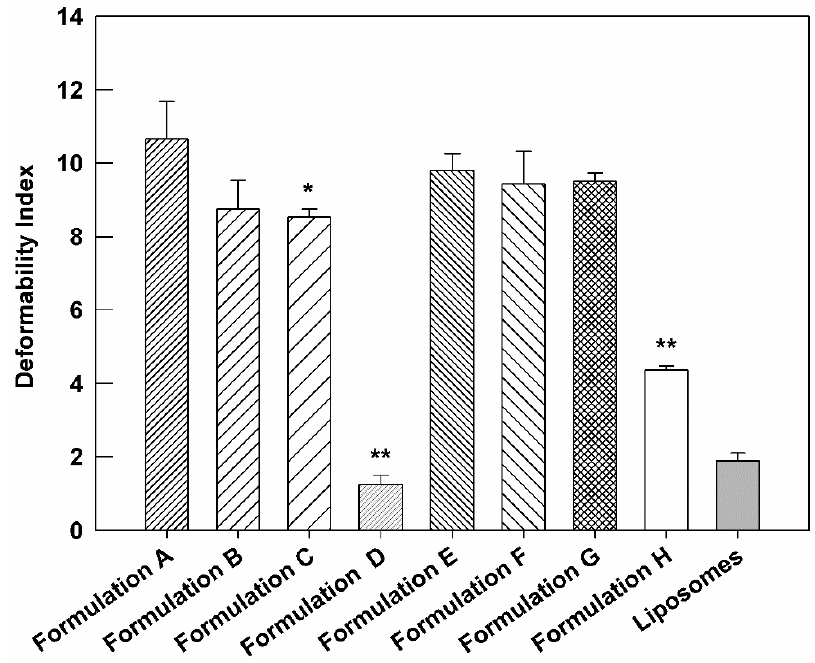
Figure 5. Deformability Index of compound(s)-loaded ultradeformable nanocarriers formulations, compared to empty ultradeformable nanocarriers (Formulation A) and liposomes, used as negative control. The results are expressed as the mean value of five independent experiments ± standard deviation. * p < 0.05 and ** p < 0.001 of formulation vs. Formulation A.